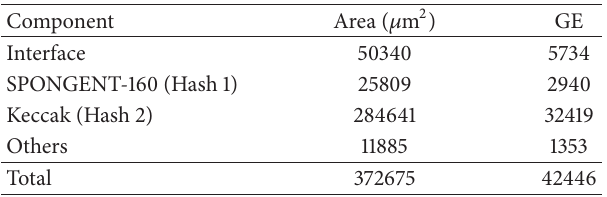
Table 1: Area and GE (gate equivalent) of modules in the crypto- graphic block after synthesis.